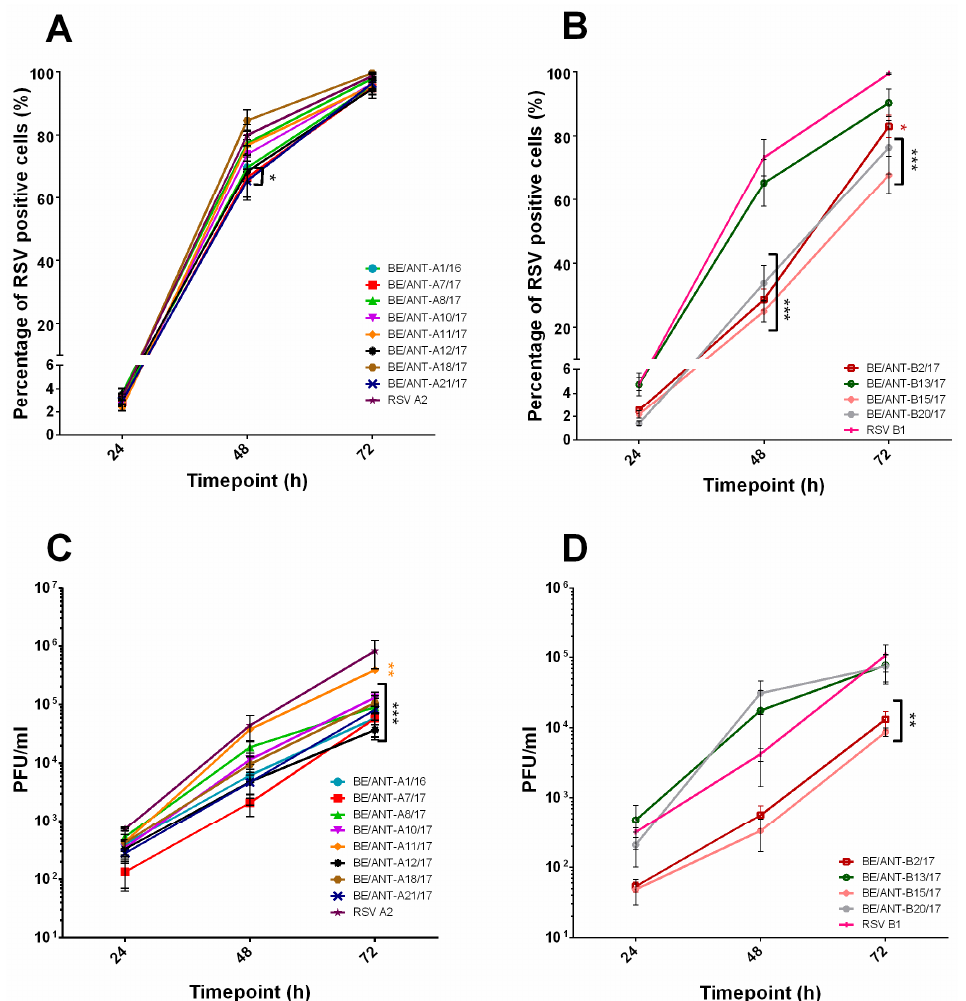
Figure 4. Replication kinetics and infectious virus production in BEAS-2B cells. ( A , B ) BEAS-2B cells were infected with clinical isolates and RSV reference strains A2 and B1. Cultures were fixed after 24 h, 48 h and 72 h, permeabilized and stained with pAb goat-anti-RSV antibody and AF488 donkey-anti-goat (IgG). Nuclei were visualized with DAPI and cultures were analysed with fluorescence microscopy. RSV positive cells were counted and calculated to the total number of nuclei to reach a percentage of RSV infected cells. ( A ) Replication kinetics of RSV-A clinical isolates and ( B ) Replication kinetics of RSV-B clinical isolates. ( C , D ) BEAS-2B cells were infected with clinical isolates and RSV reference strains A2 and B1. After 24 h, 48 h and 72 h, supernatants were collected and used for quantification by conventional plaque assay. Data represents mean values ± SEM ( n = 3), significant di ff erences compared to the reference strains are indicated by * p < 0.05; ** p < 0.01 ***; p < 0.001 (two-way ANOVA).